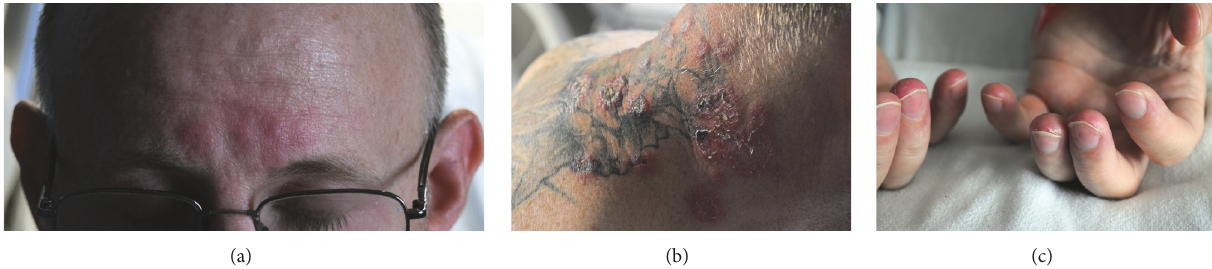
Figure 1: Skin findings . (a) Edematous papules and plaques of acute lesions of Sweet’s Syndrome. (b) Well-established lesions of Sweet’s Syndrome consisting of annual papules and plaques with scale and crust. (c) Finger changes seen in our patient with subungual inflammation splinter hemorrhages and inflammation and scaling of several fingertips.